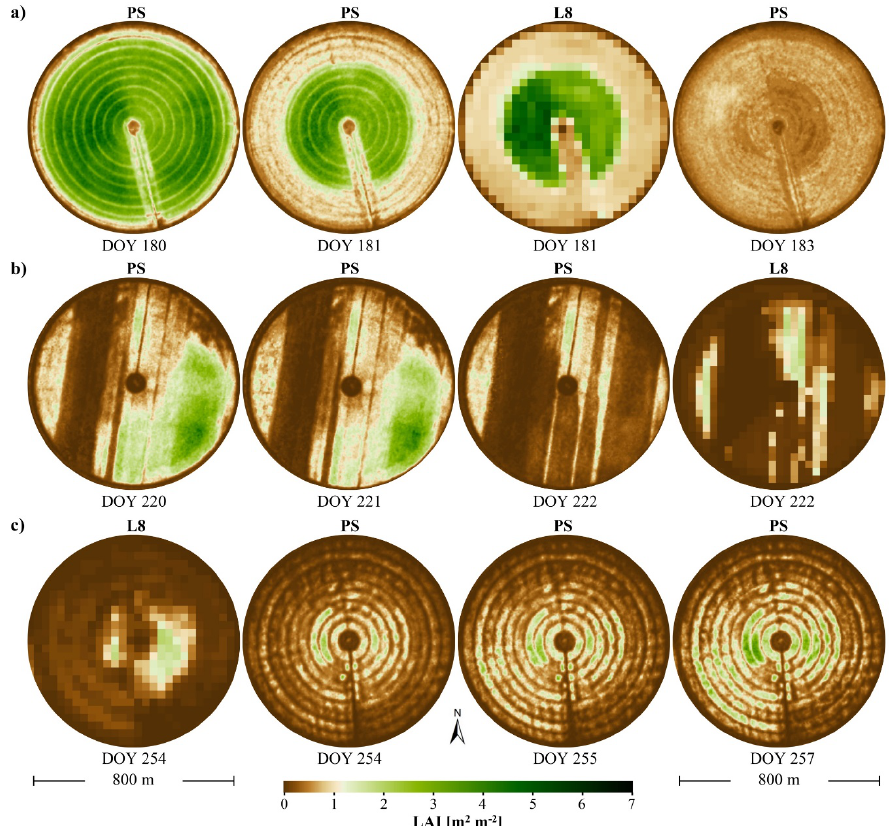
Figure 8. Events of rapid (i.e., from day to day) change in LAI over selected pivots across the study domain. ( a ) Timing of a harvesting event captured by daily PlanetScope (PS) LAI (DOY 180–183) whereas L8 LAI is only available on DOY 181. ( b ) Timing of intrafield transitions from high to low LAI captured by daily PS LAI (DOY 220–222) whereas L8 LAI is only available on DOY 222. ( c ) Rapid green-up development tracked by PS LAI (DOY 254–257) whereas L8 LAI is only available on DOY